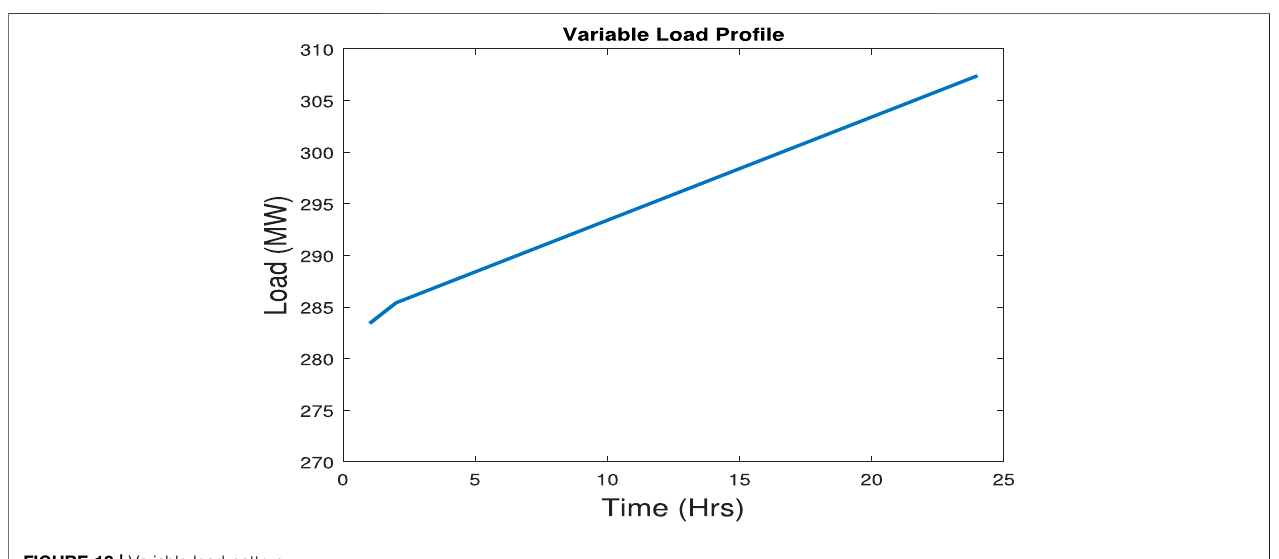
FIGURE 12 | Variable load